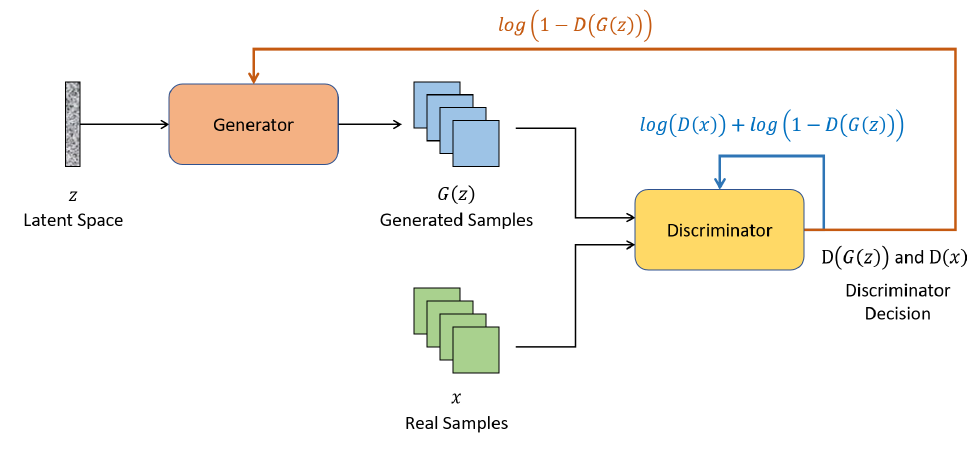
Figure 2. Typical Generative Adversarial Networks (GAN)